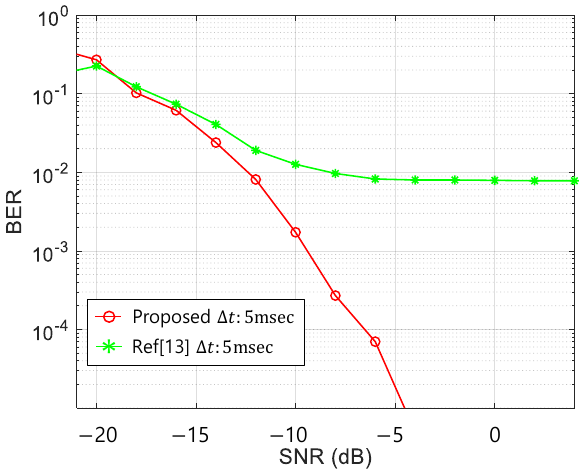
Figure 10. BER result in Under Water Acoustic (UWA) channel.